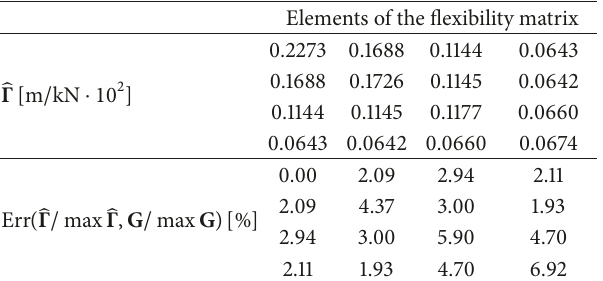
Table 6: Flexibility matrix obtained by using identified left singular vectors (from SVD-based procedure) and relative errors.